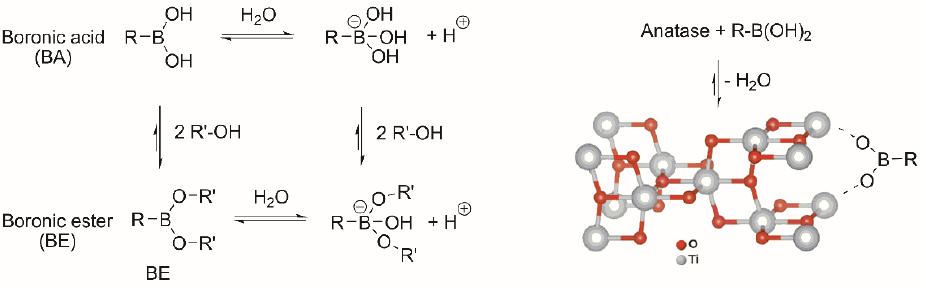
Figure 2. pH-dependent equilibrium of boronic derivatives (BA and BE) and plausible interaction between boronic acid and TiO 2 surface (anatase).